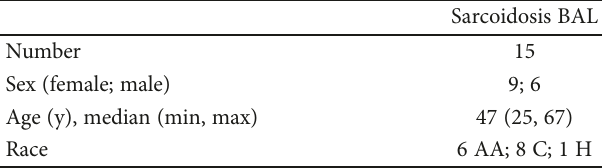
Table 2: Demographics of sarcoidosis BAL population.